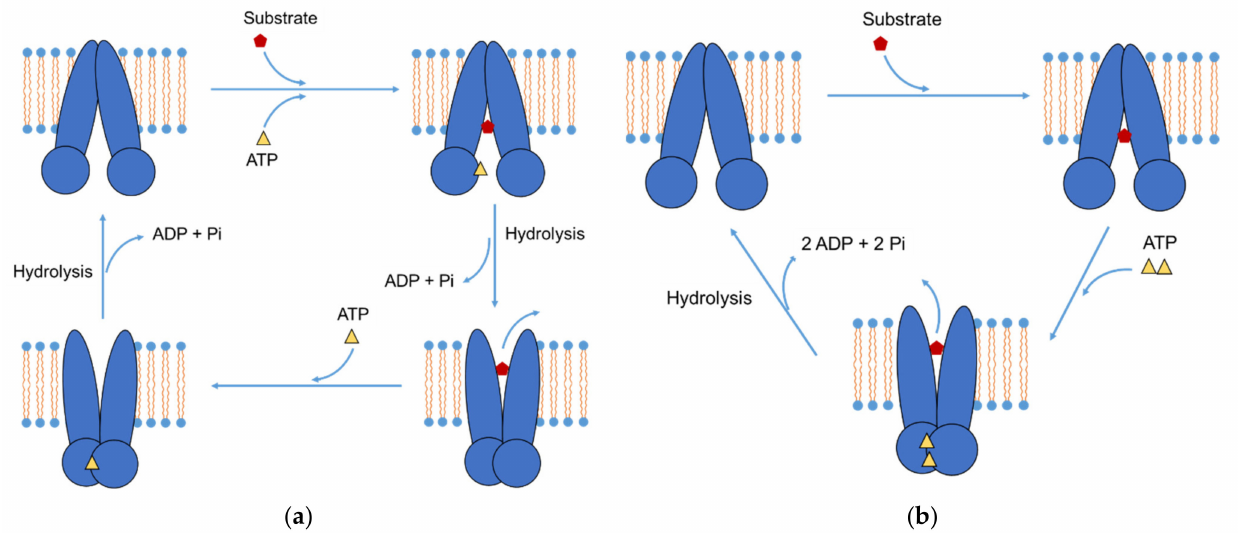
Figure 1. P-gp efflux mechanism. ( a ) “ATP hydrolysis as the power stroke” model and ( b ) “dimerization of the two ATP-binding sites as the power stroke” model describing the transport cycle of